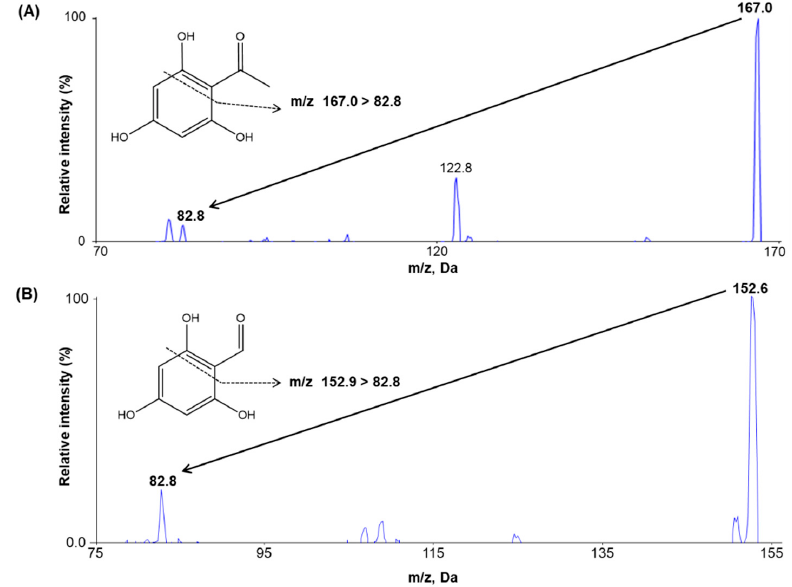
Figure 1. Product ion mass spectra and the fragmentation pattern of ( A ) 2 ′ ,4 ′ ,6 ′ - Figure1. Productionmassspectraandthefragmentationpatternof( A )2 (cid:48) ,4 (cid:48) ,6 (cid:48) -trihydroxyacetophenone trihydroxyacetophenone (THAP) and ( B ) trihydroxybenzaldehyde (internal standard, IS). (THAP) and ( B ) trihydroxybenzaldehyde (internal standard,